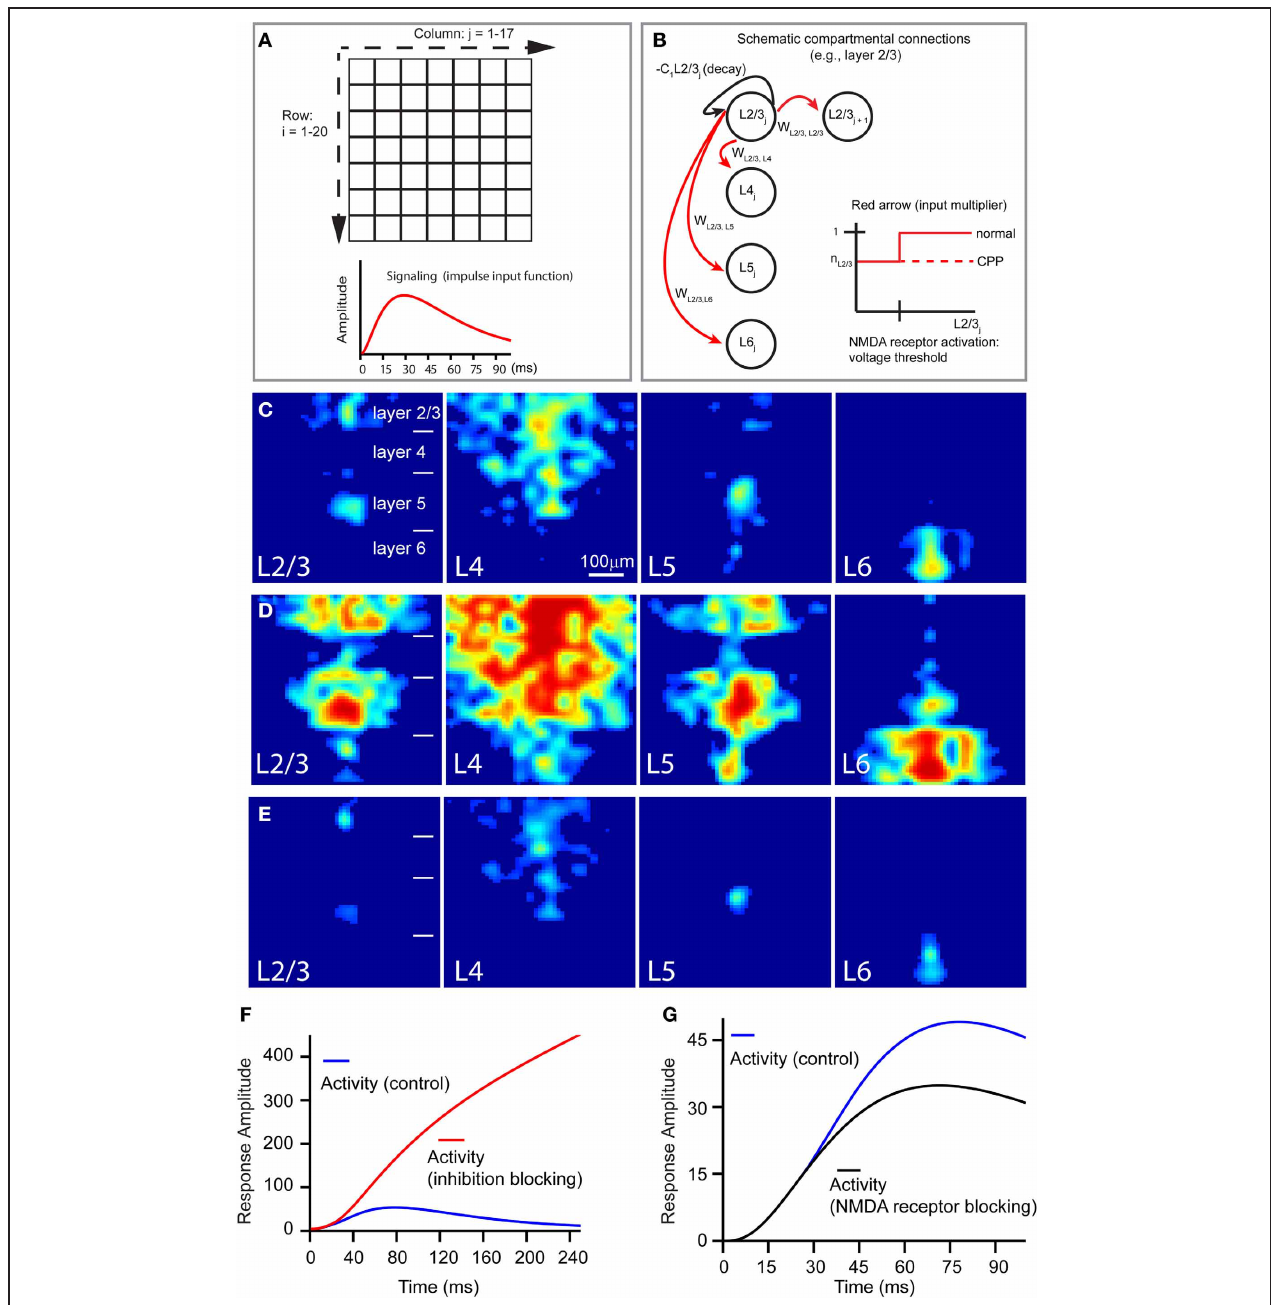
compartments; the impulse input depicted below the grids. In the schematic shown in (B) , the following features of the model are illustrated: compartmental connections with layer-specific connection weights, compartmental activity decay, and NMDA-mediated voltage-dependence of compartmental responsiveness to input. (C) Shows the simulated slice’s peak activation spread ( ∼ 70ms) in response to stimulation of L23, L4, L5, and L6, respectively. (D) Shows the late stage ( ∼ 150ms) of slice activation profiles with inhibition blocked. (E) Is same as (C) , except in the absence of NMDA conductance. (F and G) Show how the temporal evolution of overall system activity produced by layer 4 stimulation is affected by loss of cortical inhibition and NMDA receptor blocking, respectively, relative to